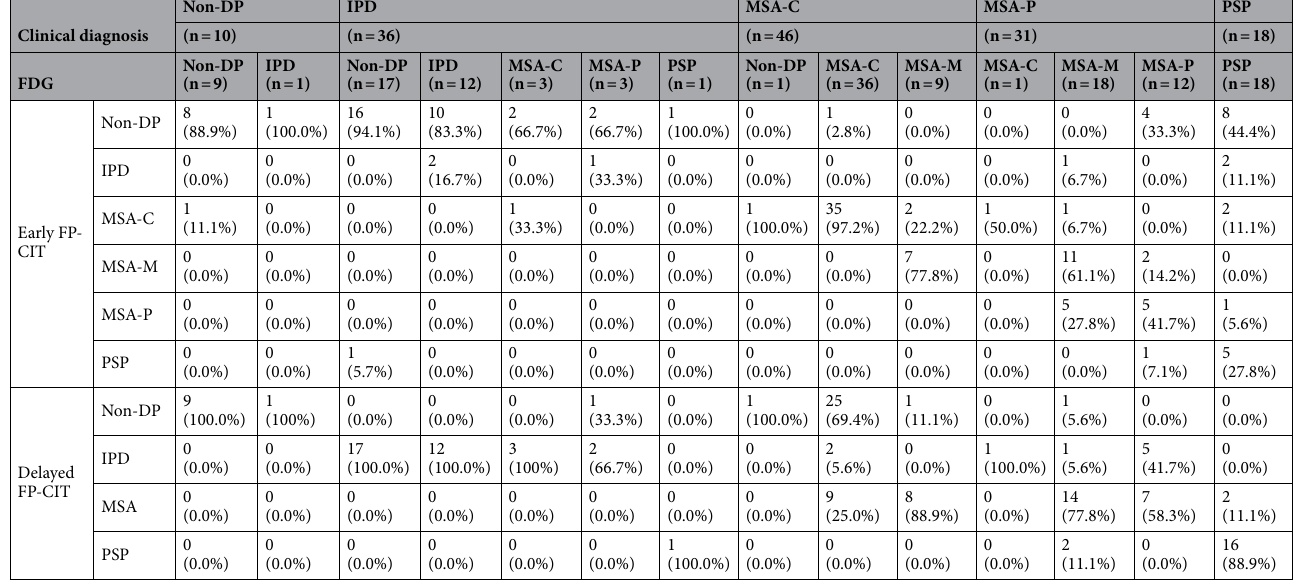
Table 4. Classification matrix of visual assessment of early and delayed phase FP-CIT PET compared to FDG PET according to clinical